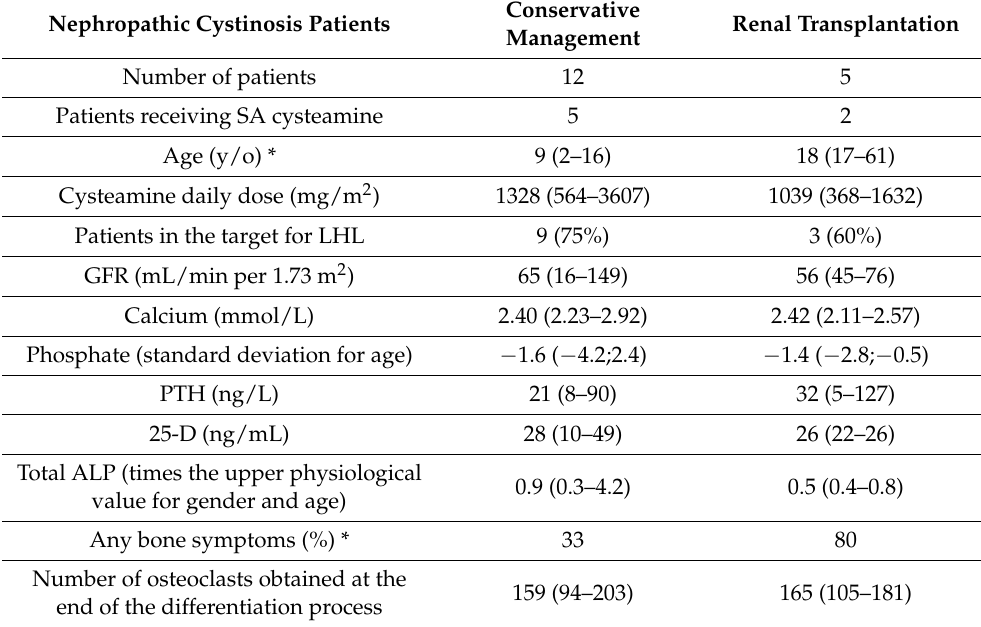
Table 3. Patients’ characteristics according to renal management